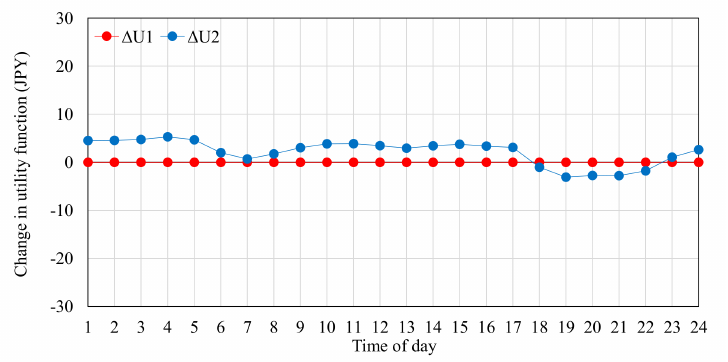
Figure 12. Changes in each function by the 1% DR request in the day of the lowest electricity consumption. In this scenario, the power suppliers could not request the DR cooperation from 18:00 to